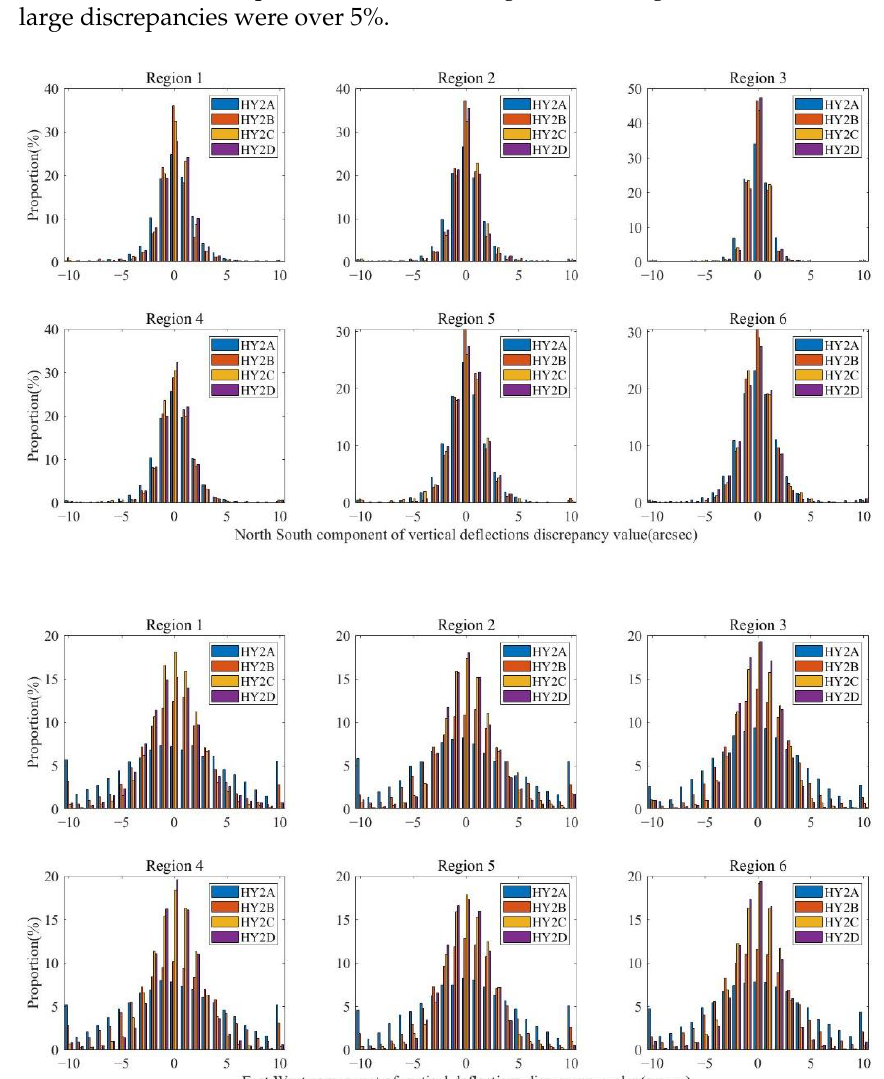
Figure 9. Distributional proportion of discrepancies between HY-2 directional components and XGM2019 model: Region 1, North Pacific; Region 2, South Pacific; Region 3, Mid-Pacific; Region 4, Indian Ocean; Region 5, North Atlantic; Region 6, South Atlantic.